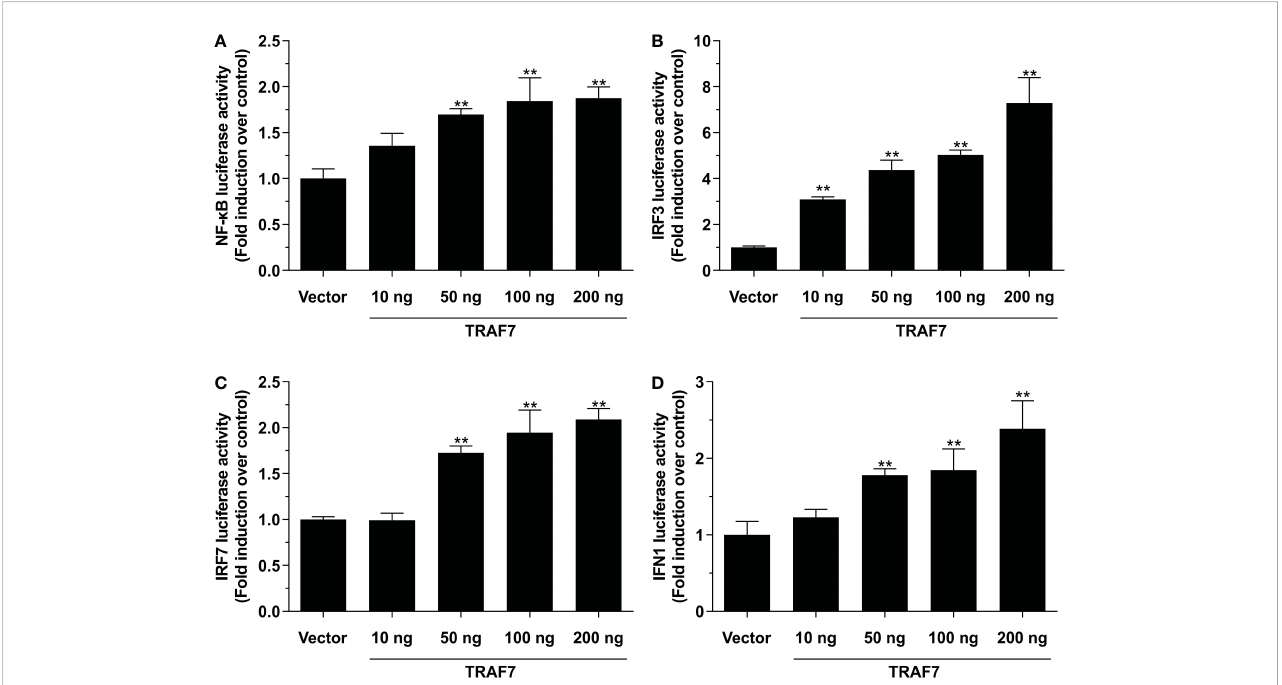
FIGURE 5 Activation of NF- k B (A) , IRF3 (B) , IRF7 (C) , and IFN1 (D) promoters by Lc -TRAF7. HEK 293T cells seeded in 24-well plates were transiently transfected with 100 ng of pNF- k B-luc, pGL4-IRF3-pro, pGL4-IRF7-pro, or pGL4-IFN1-pro, 10 ng of pRL-TK together with the increasing amounts of pcDNA3.1-TRAF7 or pcDNA3.1 (vector control). At 24 hpt, the cells were harvested for detecting luciferase activity, with the results normalized to the Renilla luciferase activities and exhibited as the fold induction relative to the control group transfected with the pcDNA3.1 empty vector. All data were shown as mean of three independent experiments, with bars representing the SE. ** P <